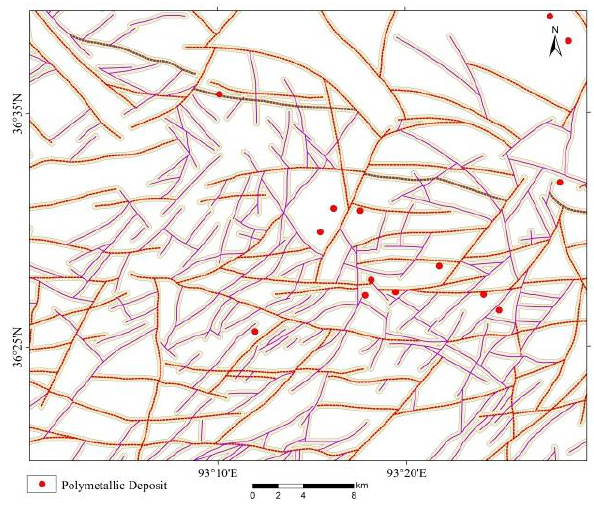
Figure 6. Linear construct buffer.